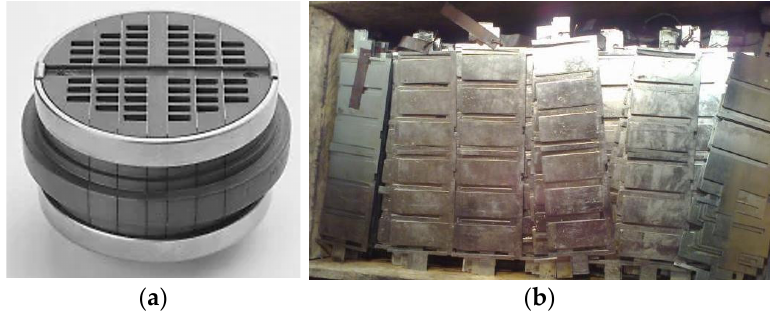
Figure 11. A valve ( a ) and type of valve plates ( b